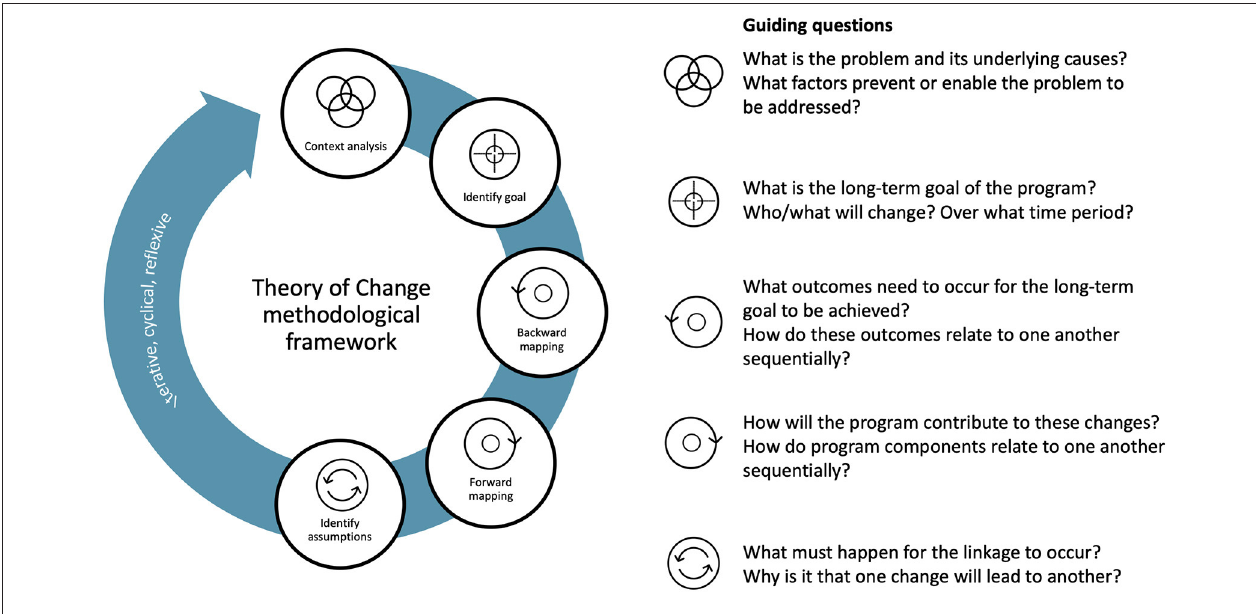
FIGURE 1 | Theory of change methodological framework and guiding questions.